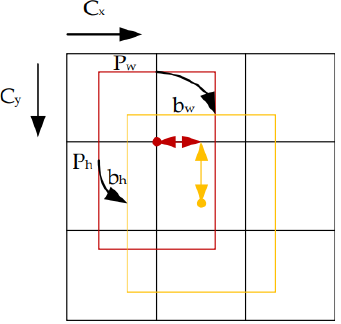
Figure 7. Decoding of prediction bounding box in YOLOv5, acquired from [35].